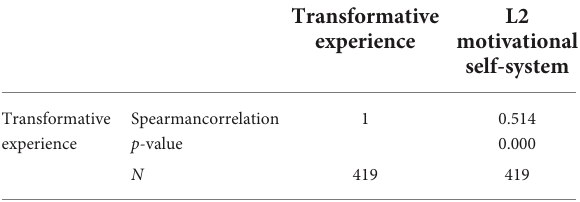
TABLE 5 Spearman’s correlation coefficient for transformative experience and L2 motivational self-system.